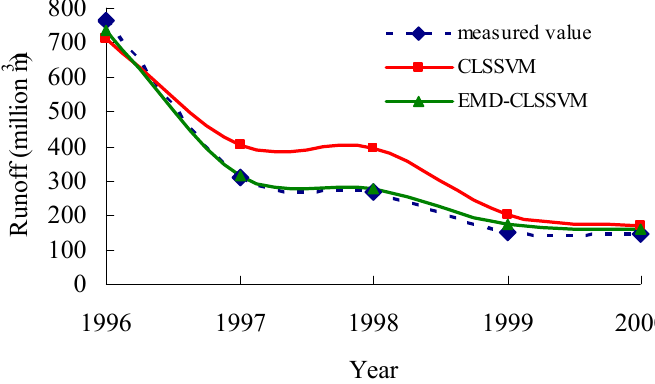
Figure 13. Prediction results of annual runoff for Zhaishang station.